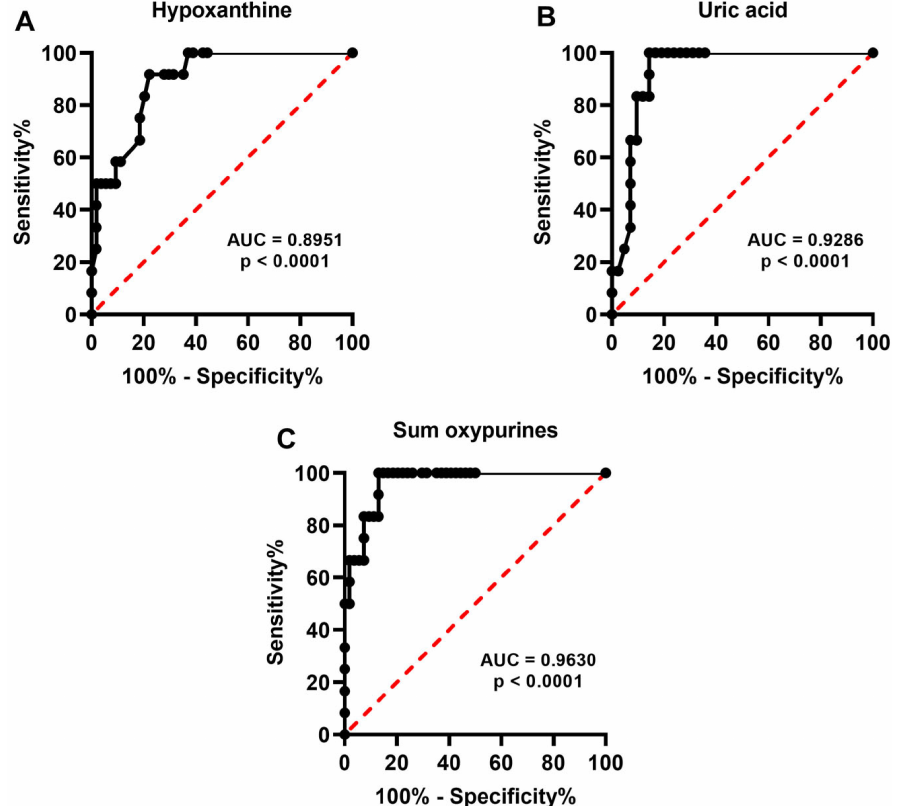
Figure 5. Receiver Operating Characteristic (ROC) curves of hypoxanthine ( A ), uric acid ( B ), and sum oxypurines ( C ) determined in the culture media of the two groups of human embryos categorized ac- cording to morphological quality using the Gardner scale system. The significance of the Area Under the Curve (AUC) is indicated in each panel. The sum of oxypurines = hypoxanthine + uric